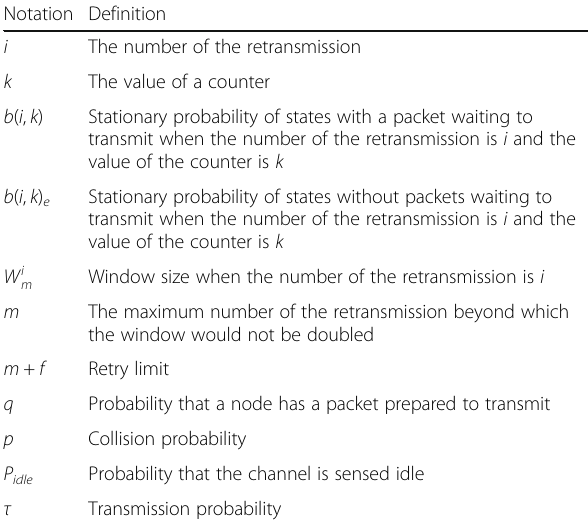
Table 1 Notations used in the Markov model Notation